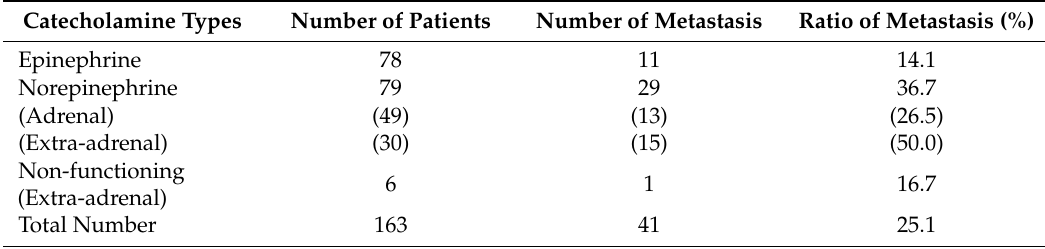
Table 4. Catechoamine types, tumor locations and